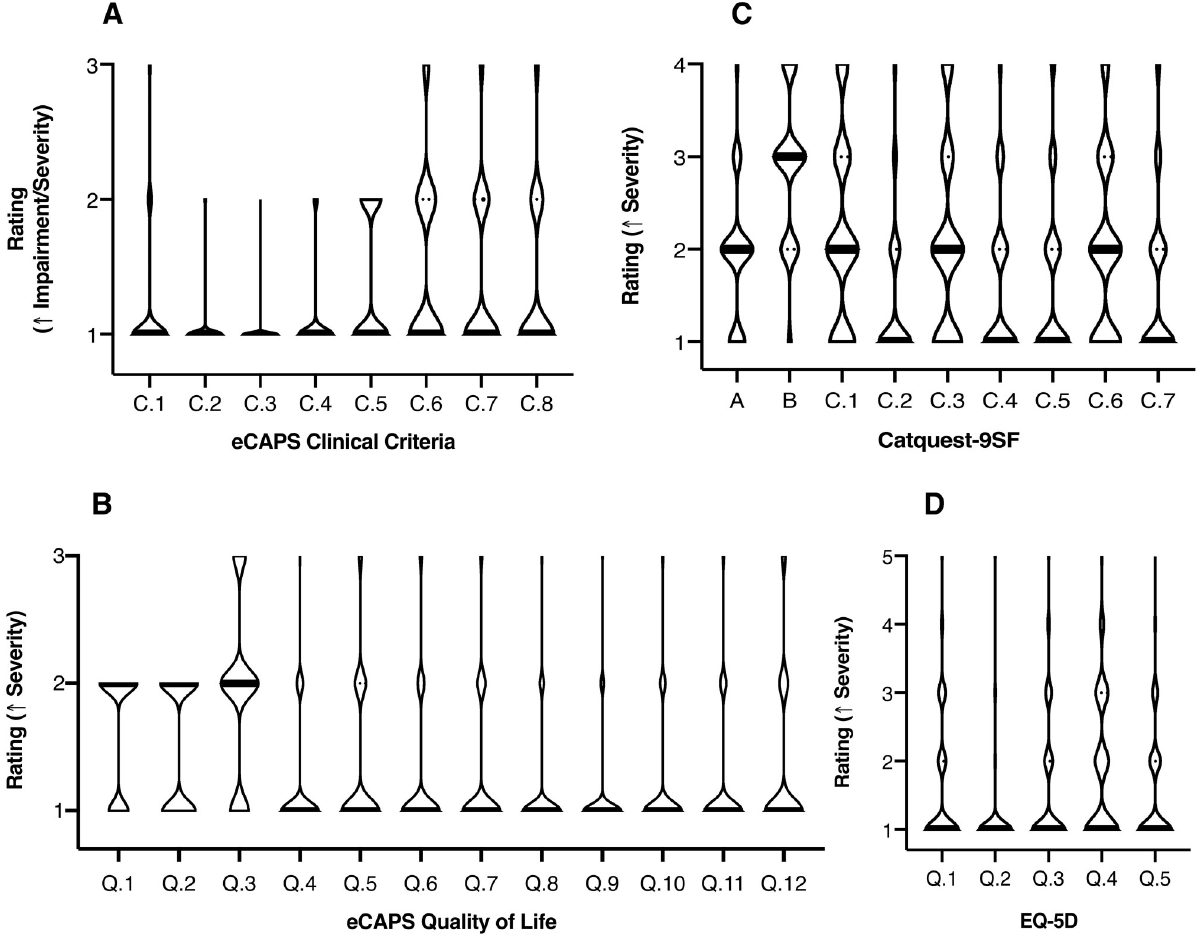
Fig 2. Violin plots of clinical criteria and questionnaire ratings. Median plotted as solid thick lines, with quartiles as dotted lines. (A) eCAPS Clinical Criteria; (B) eCAPS Quality of Life; (C) Catquest-9SF; (D) EQ-5D.